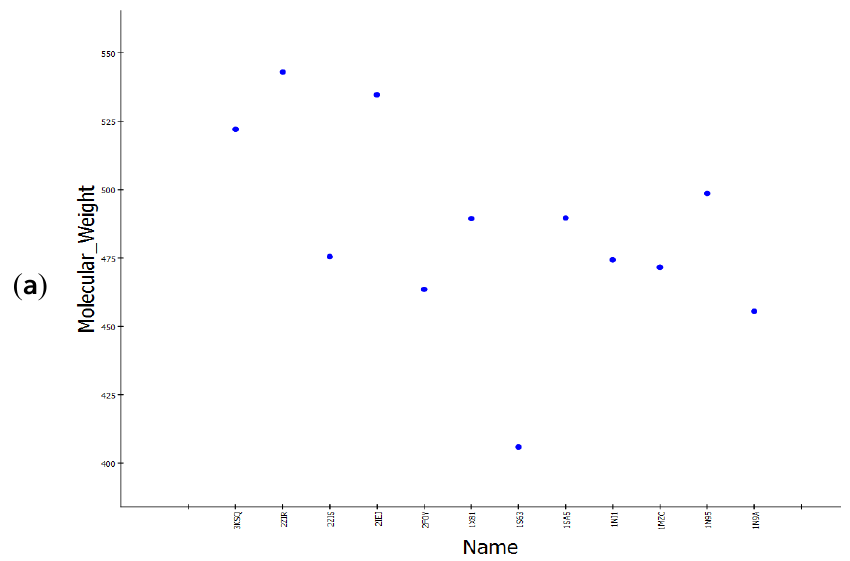
Figure 2. Molecular properties distribution of the fourteen crystal structures used for common feature pharmacophore. ( a ) Molecular weight scale. ( b ) Molecular solubility, Number of aromatic rings, Kappa_1, and